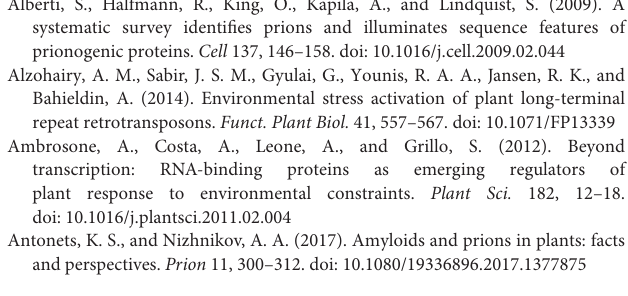
Supplementary Figure 1 | Gene ontology (GO) enrichment analysis of prion-like proteins (PrLPs) from the organisms used in the study. Heat maps depicting (A) molecular functions, (B) biological processes, and (C) cellular components, enriched in all 39 species. Heatmaps were generated using the R package.